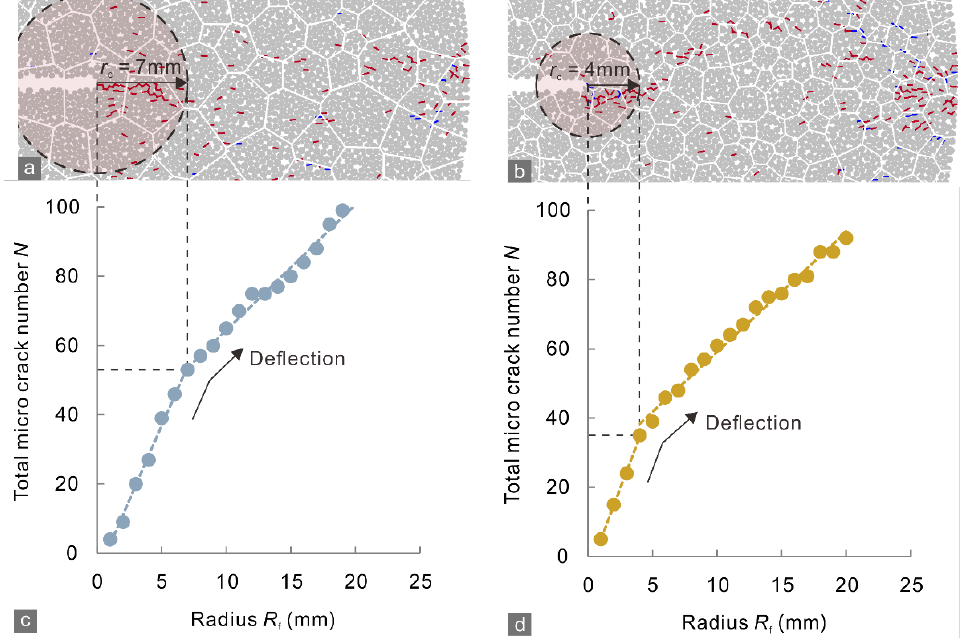
Figure 13. Micro-crack distributions near the notched crack tips in the ( a ) marble A and ( b ) J specimens at the peak applied load in the CCNBD simulation. ( c , d ) Total number of micro-cracks in tip-centered circles with different radii. The red and blue curves in ( a , b ) indicate intra- and inter-grain micro-cracks. The dashed lines in ( c , d ) are fitting lines for the distribution of the solid circles.